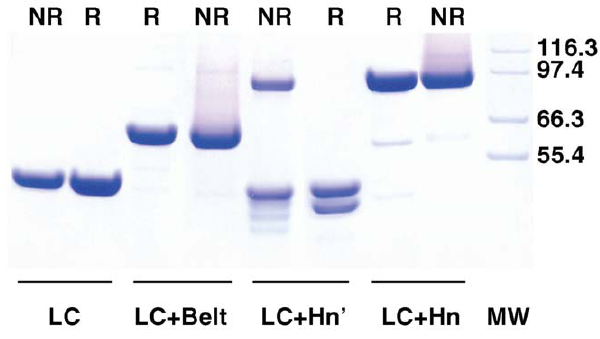
Figure 3. Reducing (R) and non reducing (NR) SDS-PAGE of various forms of the LC used. Samples (0.15 mg/ml) were heated at . 95 u C for 5 min without (NR) and with (R) 5% b -mercaptoethanol in the SDS-load buffer before electrophoresis. Molecular mass in kDa of the marker proteins in the right lane are shown at right.